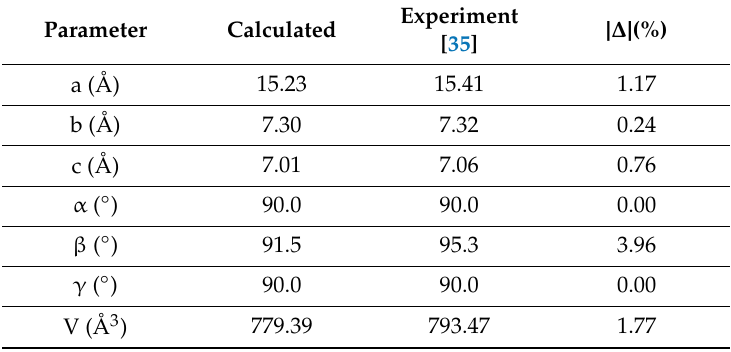
Figure 1. Crystal structure of CaSiO 3 . Table 2. Calculated and experimental structural parameters of CaSiO 3. Percentage difference between the calculated and the experimental value ( ∆ ) is also provided.